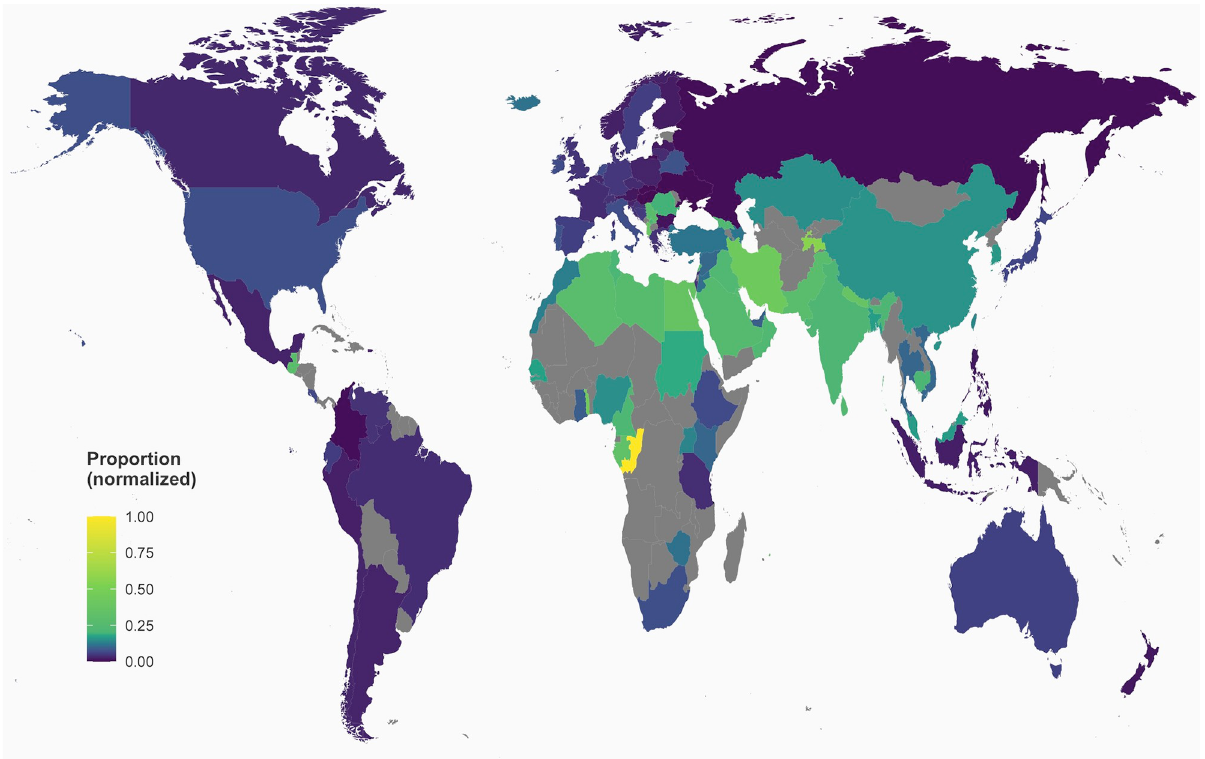
Fig 1. Proportion of retracted research articles by country. Proportion of retracted research in relation to all peer-reviewed documents published in 2010–2015 for countries with > 500 peer-reviewed documents within those 6 years, as indicated by the National Science Foundation (see Materials and Methods). This varies substantially by country and by continent. The continent with most retractions is Asia and the continent with least retractions is Europe. The country with the highest proportion of retractions was the Republic of Congo (3/922; 0.3%) and the country with the least proportion was Hungary (3/55,609, 0.005%). Note that NSF counts of total peer-reviewed documents do not include letters, which represent 21/4,603 (0.5%) of our research articles as per our eligibility criteria. Grey signifies no data for those